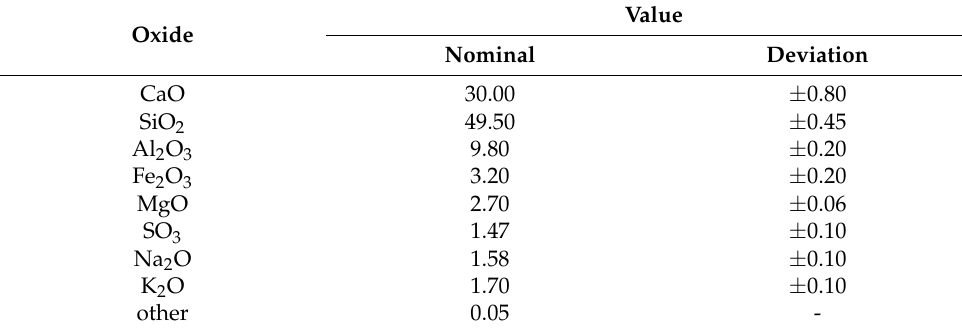
Table 1. Chemical composition of the concrete scrap, %.